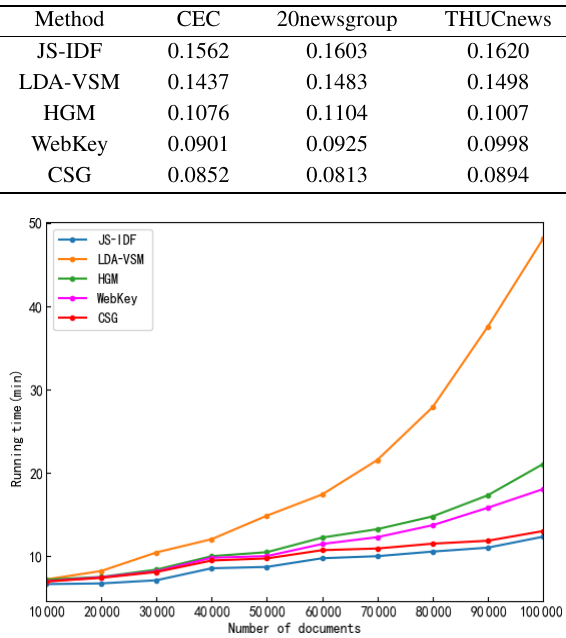
Fig. 4 Run time comparison